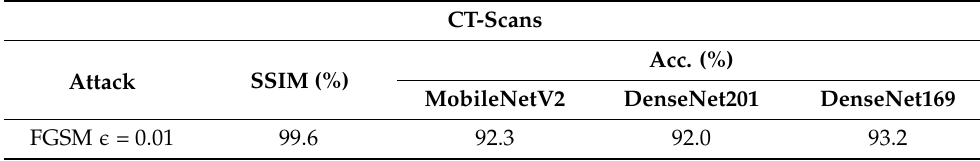
Table A9. SSIM index and performance for each attack in